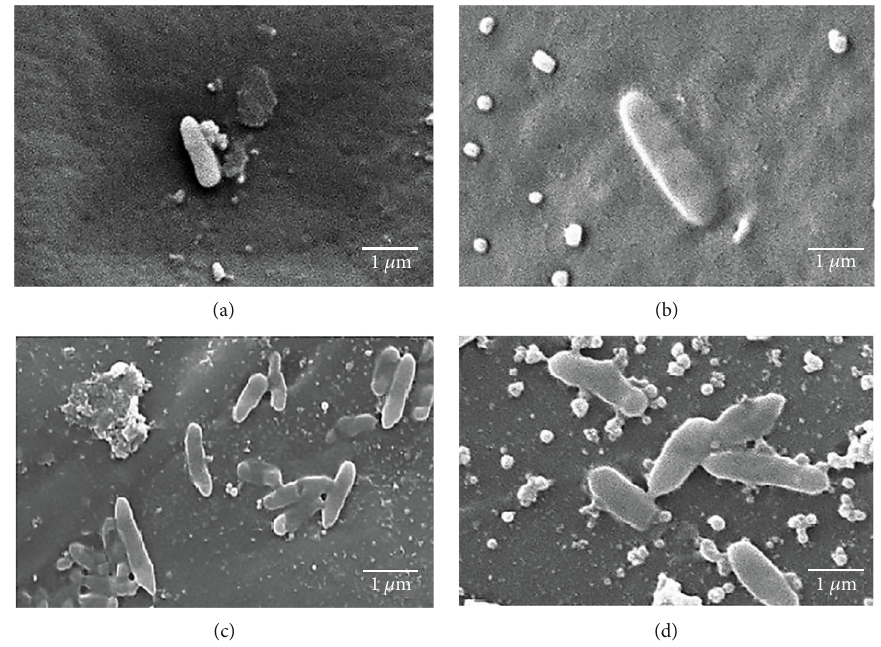
Figure 8: SEM images of E. coli bio fi lm adhesion on (a) PSM50, (b) PSM40, (c) PSM30, and (d)